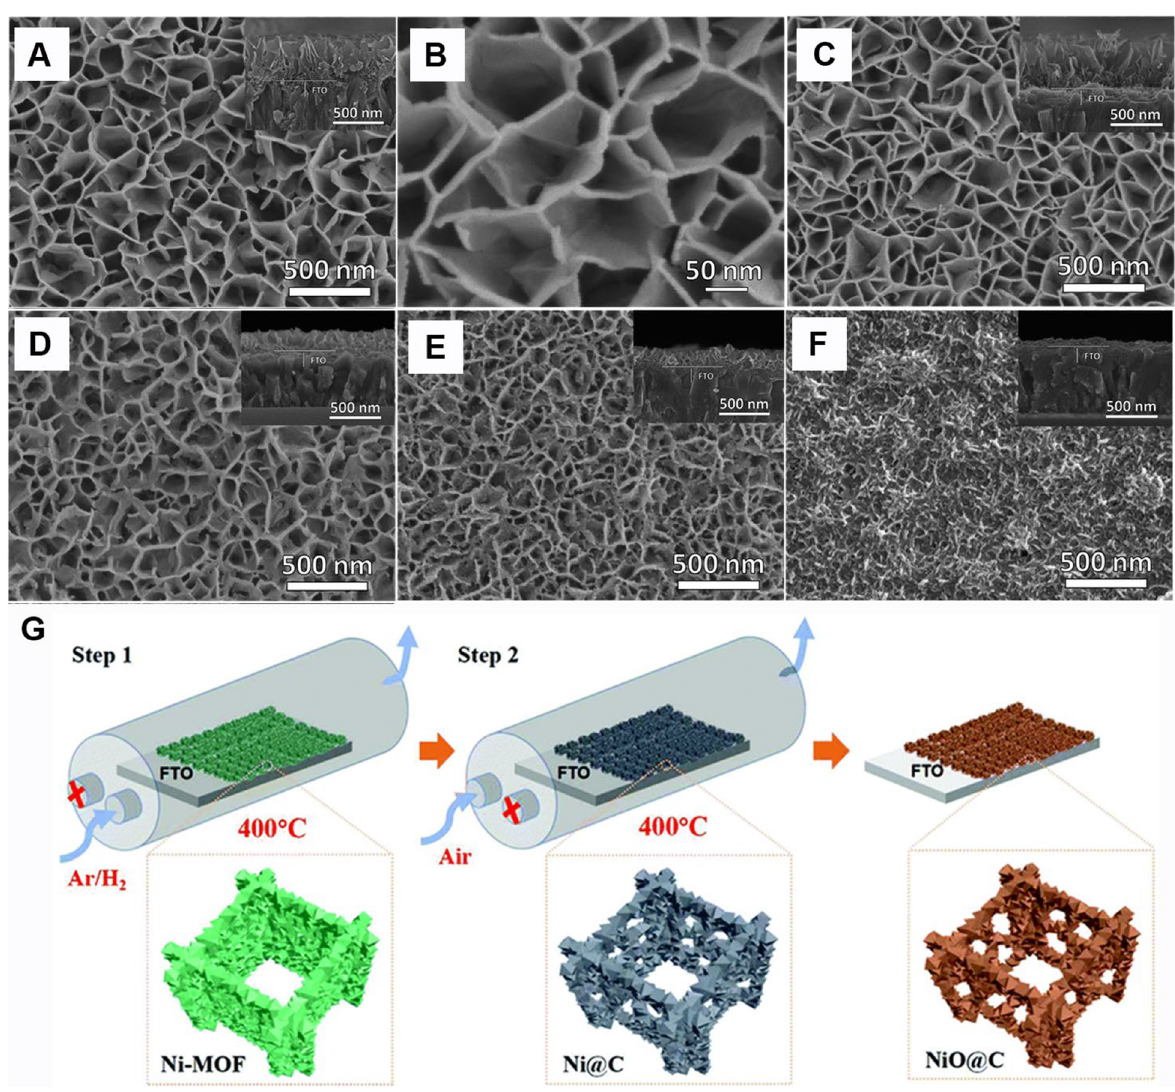
Figure 12: Characterization of NiO-based electrochromic films. Scanning electron microscope (SEM) images of the films: (A and B) undoped NiO, (C) NiO – Co 0.3%, (D) NiO – Co 0.5%, (E) NiO – Co 1%, and (F) NiO – Co 3% (cross-sectional view is presented in the inset). Reproduced with permission from Ref. [180]. Copyright 2014, Royal Society of Chemistry. (G) Preparation procedures of the hierarchical-porous NiO@C electrode. Reproduced with permission from Ref. [62]. Copyright 2019, Royal Society of